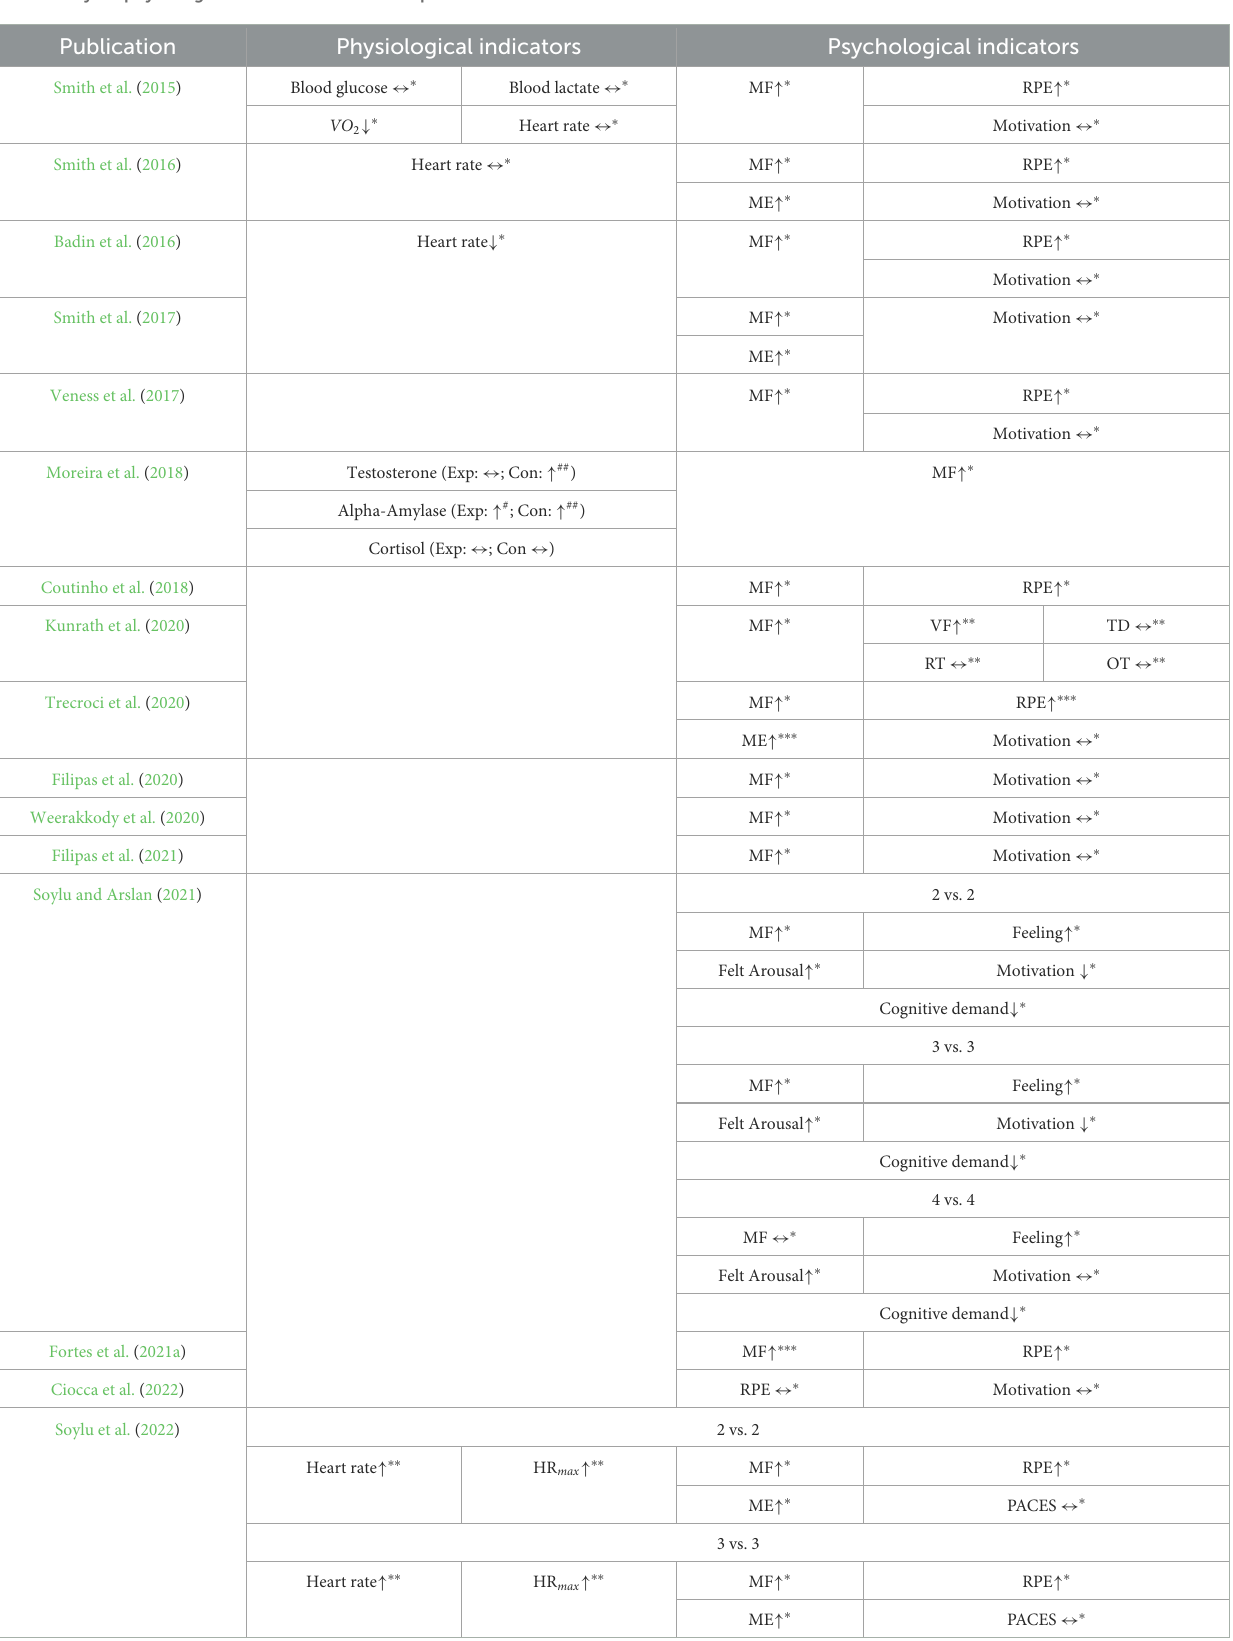
TABLE 2 Psychophysiological outcomes of included